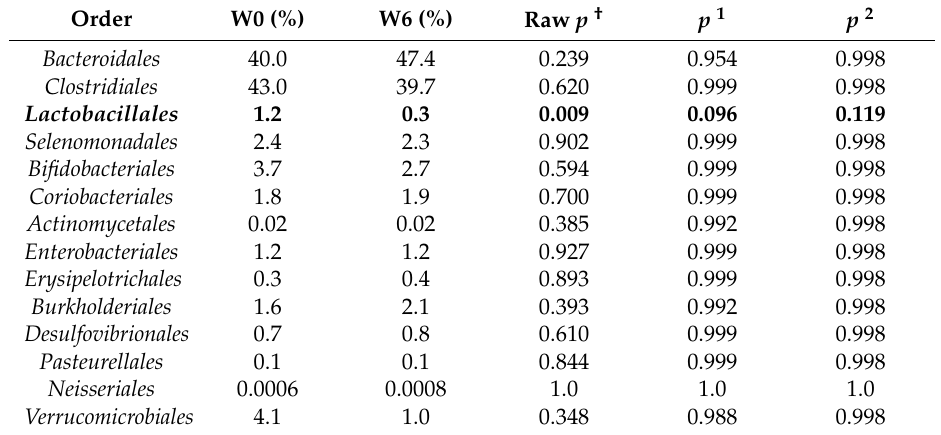
Table 5. Comparison of taxon abundance between the two time points (W0 and W6) at the level of